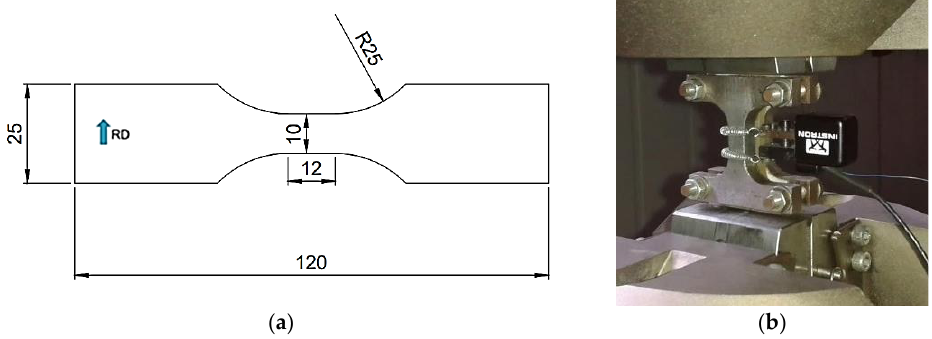
Figure 1. ( a ) LCF test specimen configuration (dimensions in mm); ( b ) strain-controlled fatigue test setup with the use of an anti-buckling device.